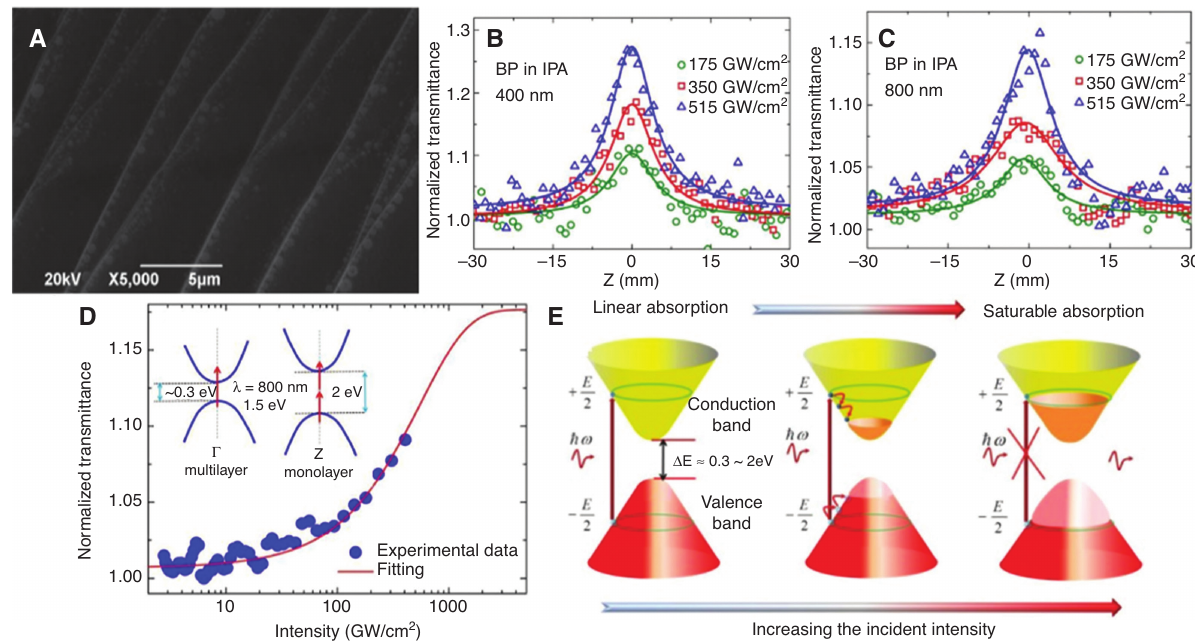
Figure 5: Nonlinear optical properties of few-layer BP. (A) SEM image of BP. (B) and (C) Open aperture Z-scan measurements of BP NPs dispersions under different intensities at 400 and 800 nm. (D) Relation between normalized transmittance and input intensity for BP nanoparticle dispersions at 800 nm. (E) Schematic diagram of the saturable absorption in multilayer BP NPs. Reproduced with permission from Ref. [133]. Copyright 2015, Optical Society of